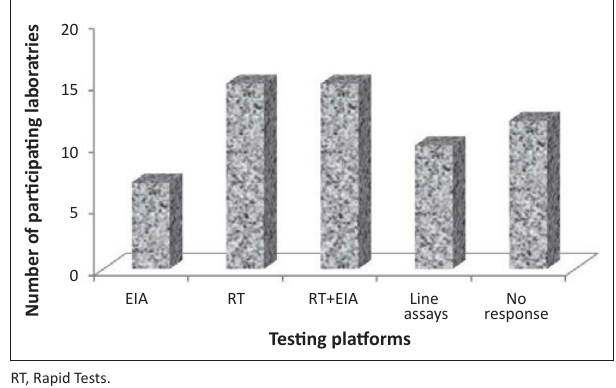
FIGURE 1: Platforms used by participating laboratories to test the proficiency testing panels 2002-2010.